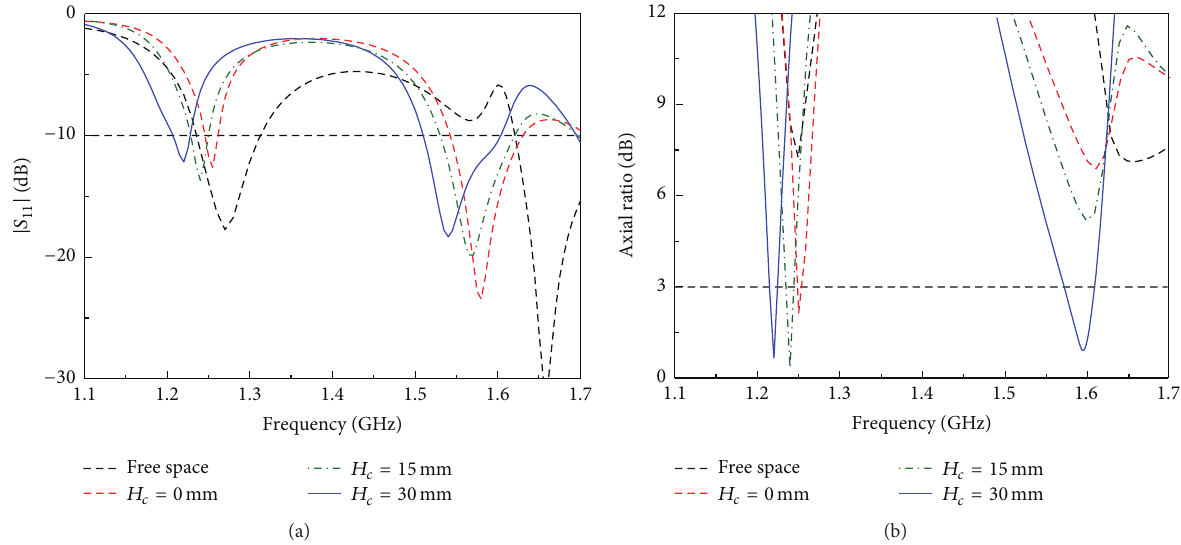
Figure 8: Simulated (a) |𝑆 11 | and (b) AR values of the asymmetrical four-arm curl antenna in different configurations.